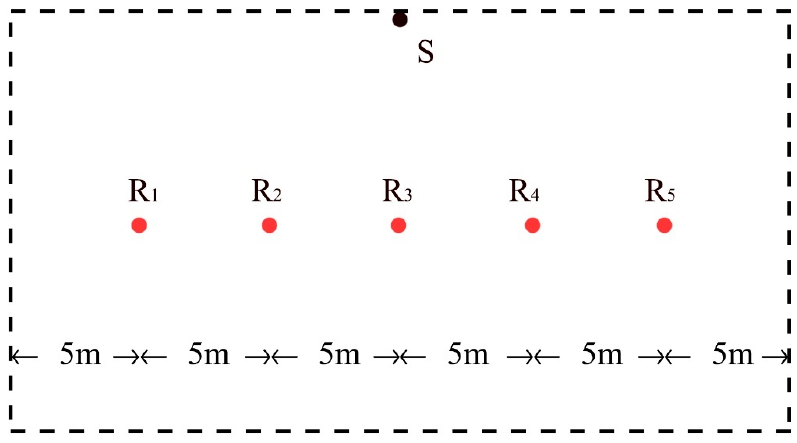
Figure 5. The acoustic environment measurement in the survey zone: S means sound source and R means receptions.